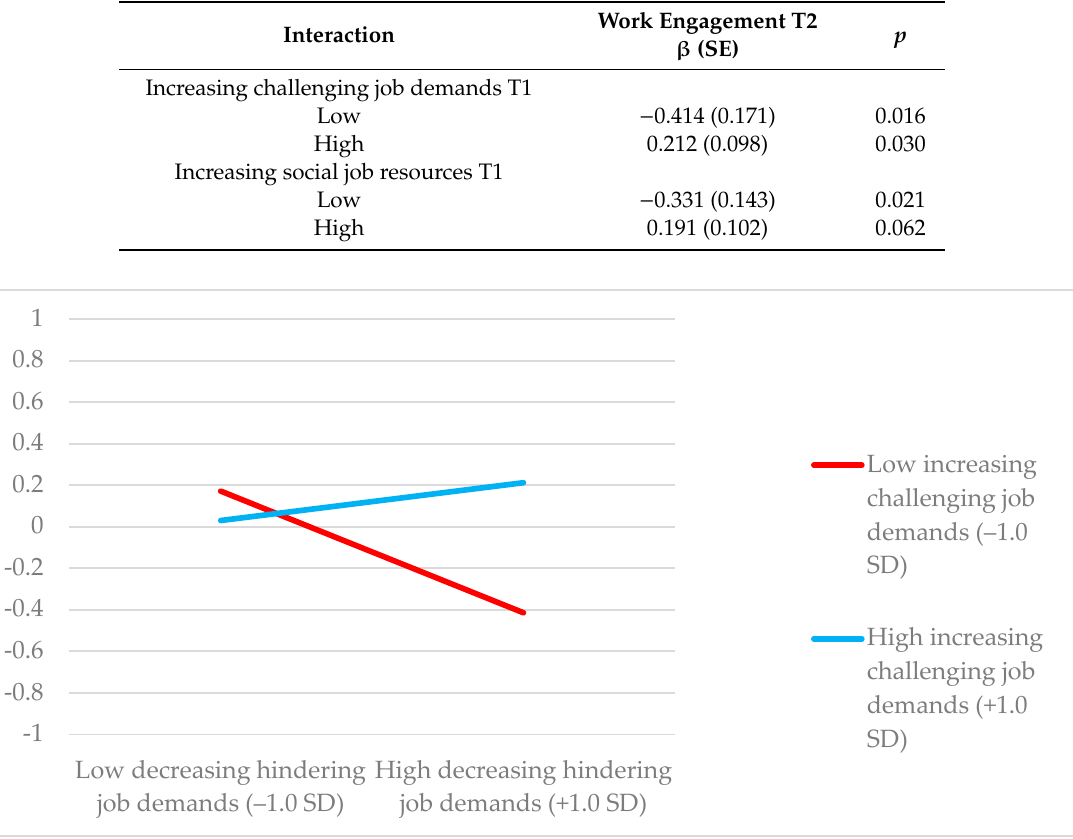
Figure 2. Interaction effect of increasing challenging job demands and decreasing hindering job demands at T1 on work engagement at T2.